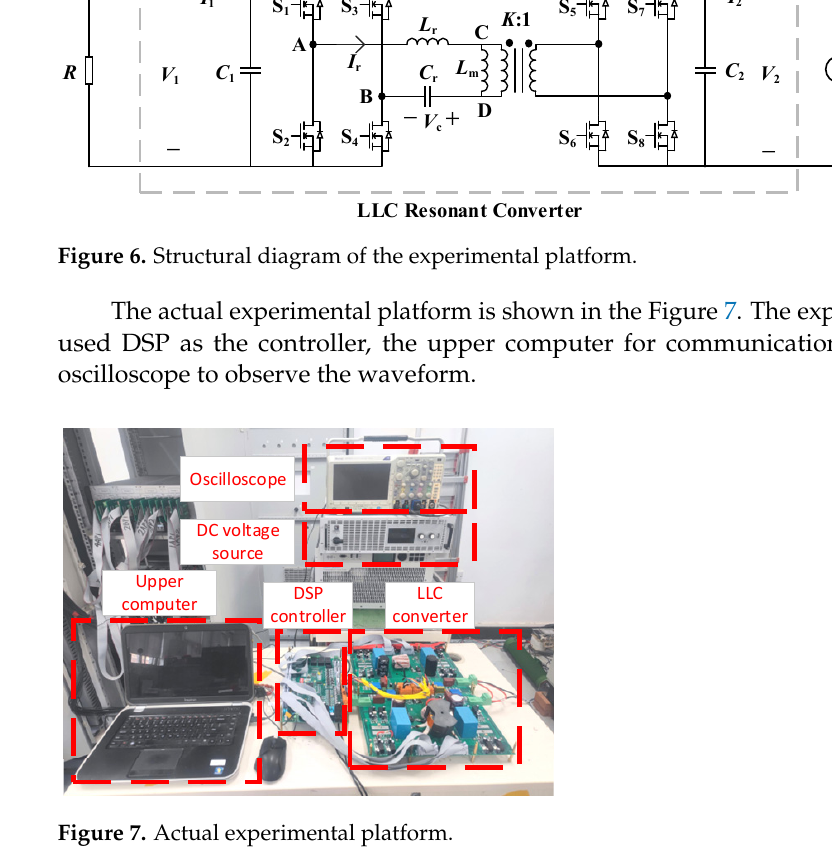
Table 2. The comparison between the proposed method and other methods.